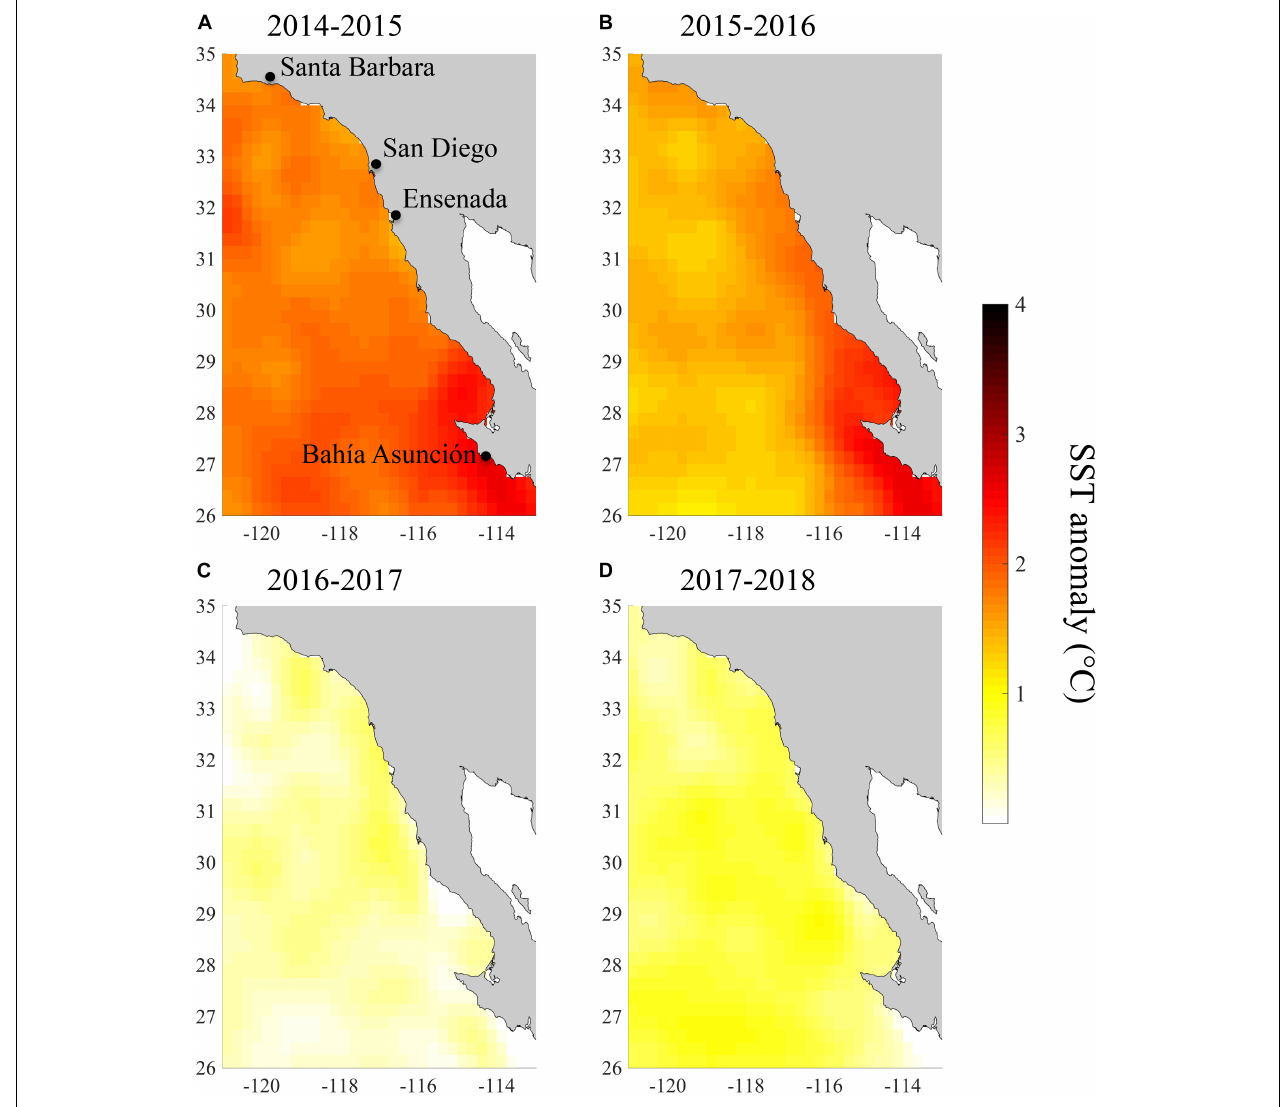
FIGURE 2 | Mean SST anomalies across the study region for (A) July 2014–June 2015, (B) July 2015–June 2016, (C) July 2016–June 2017, and (D) July 2017–June